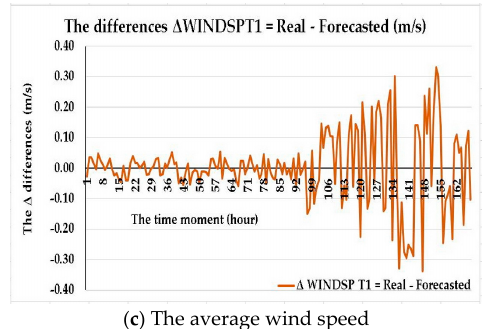
Figure 4. The differences between the real values and the forecasted ones when predicting the temperature, absolute direction of the wind, and average wind speed for Turbine 1.